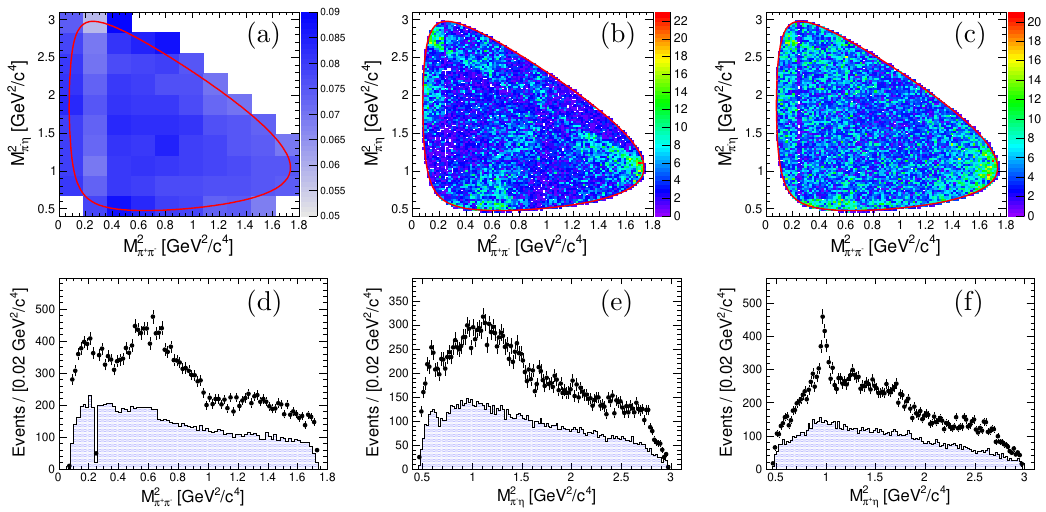
Figure 2 . For D 0 → π + π − η : (a) distribution of reconstruction efficiencies over the Dalitz plot, divided into 10 × 10 bins of M 2 vs M 2 . The red lines indicate the Dalitz plot boundaries. π + π − π − η (b) Dalitz plot for events in the Q signal region | Q − 5 . 86 | < 0 . 80 MeV. (c) Dalitz plot for events in the sideband region 2 . 5 < | Q − 5 . 86 | < 4 . 90 MeV , used to estimate the background shape. (d, e, f) Projections of Dalitz variables M 2 , M 2 , and M 2 , respectively. Points with error bars show π + η π + π − π − η events in the signal region; blue-filled histograms show the estimated background (see text). The dip in M 2 near 0 . 25 GeV 2 /c 4 is due to the K 0 π + π − S